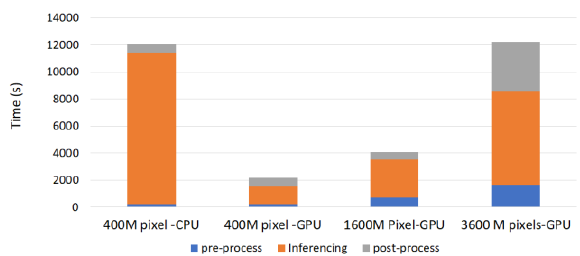
Figure 9. Comparison of time taken for MAPLE workflow for different image size for CPUs and